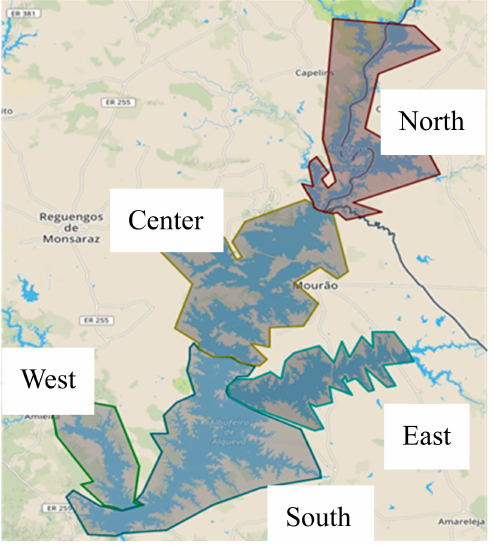
Figure 10. Selection of areas according to seasonal variation of water quality parameters, width and geometry of the